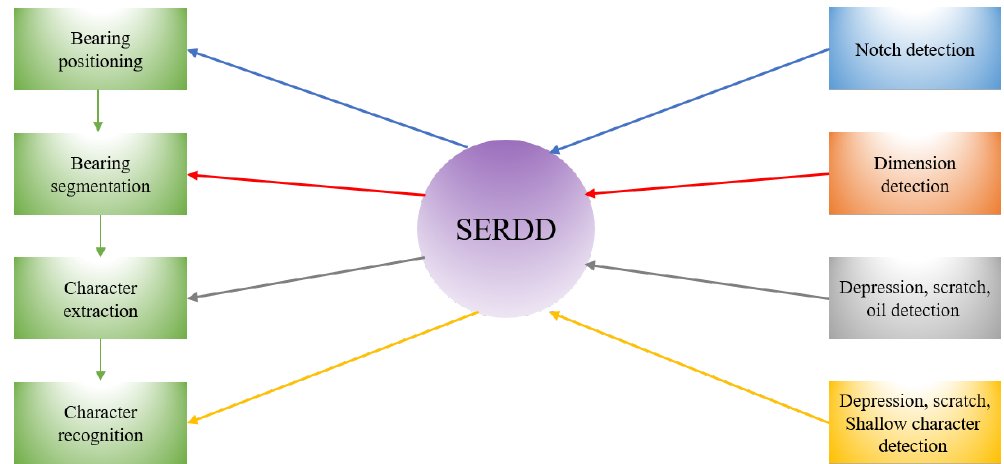
Figure 1. Schematic diagram of Segmented Embedded Rapid Defect Detection Method for Surface Defects (SERDD).